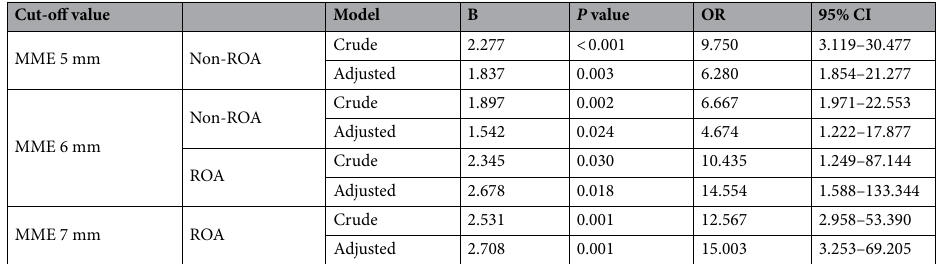
Table 2. Logistic regression analysis to elucidate the relationship between the cut-off value of medial meniscus extrusion and the prevalence of the ghost meniscus sign. B: regression coefficient; MME: medial meniscus extrusion; OR: odds ratio; ROA: radiographic knee osteoarthritis (Kellgren-Lawrence grade ≥ 2), 95%CI: 95% confidence interval. The MME cut-off values of 5 mm in ROA and 7 mm in non-ROA group are not significantly associated with the prevalence of ghost meniscus